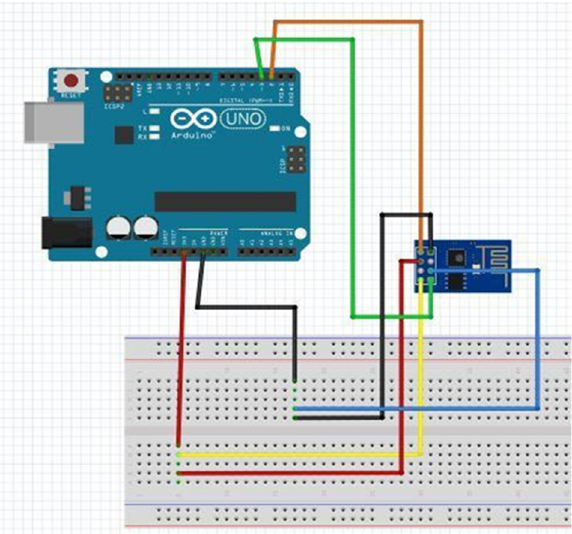
Figure 9. Connection settings for the programming of the Wi-Fi module.